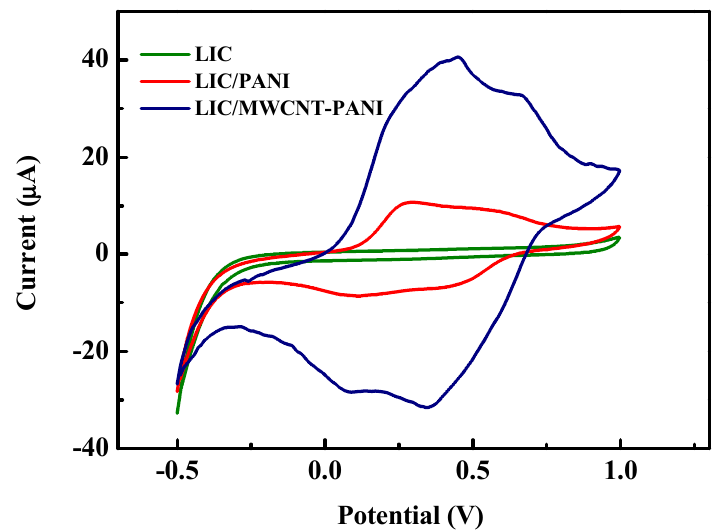
Figure 6. CV curves of prepared electrodes in 1 M HCl scan rate 50 mV·s − 1 .